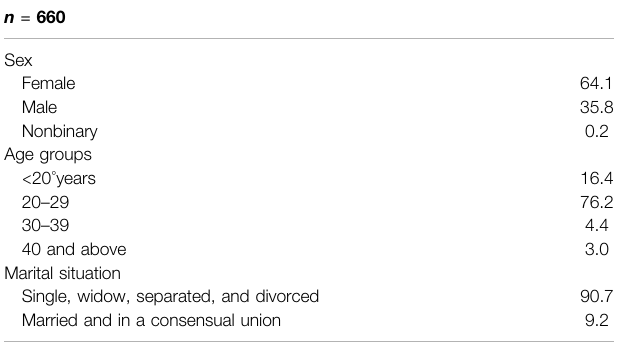
TABLE 1 | Demographic characteristics of participants.